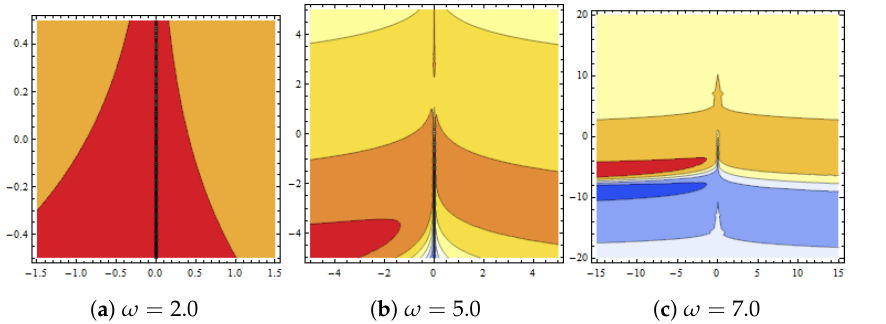
Figure 3. ( a – c ) show two-dimensional plots .